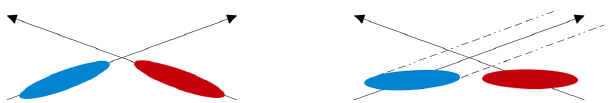
FIG. 1. Bunches colliding with a crossing angle without crab crossing (left); with the crab crossing (right).